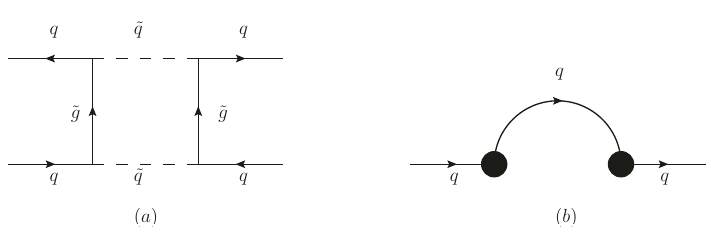
Figure 3 . Full theory diagram (a) and e(cid:11)ective diagram (b) are plotted, where the blobs denote the e(cid:11)ective vertexes, and a outgoing photon or gluon is attached by all possible ways.